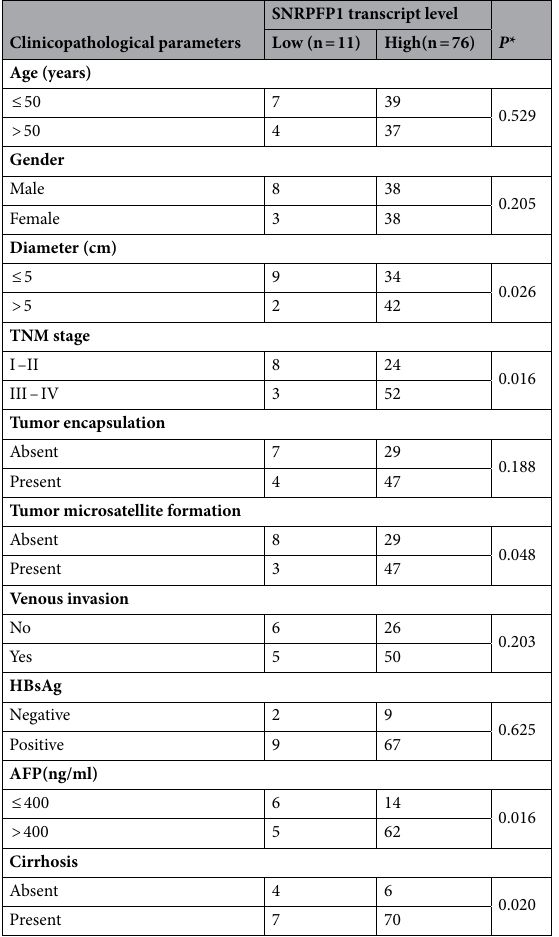
Table 1. Correlation between SNRPFP1 transcript and clinicopathological features in 87 HCC specimens. SNRPFP1 transcript level associated with clinicopathologic features in 87 HCC patients, including age, gender, tumor size, tumor stage (AJCC), tumor encapsulation, tumor microsatellite formation, vein invasion, HBsAg status, AFP level, and liver cirrhosis. Statistically, significance was assessed by Fisher’s exact